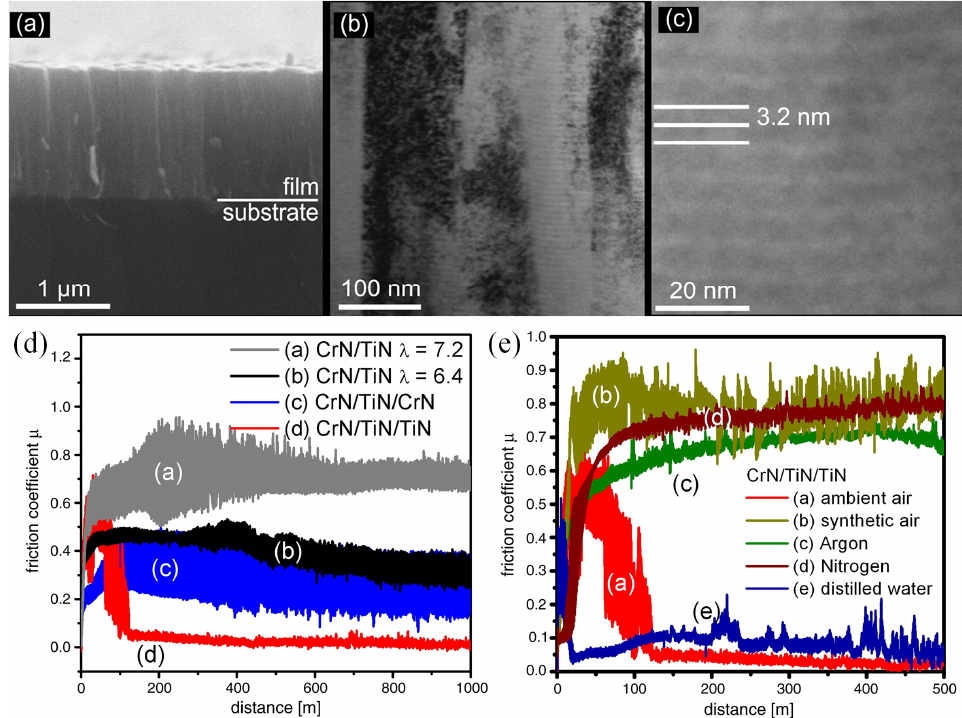
Figure 2. ( a ) SEM and ( b , c ) TEM image of multilayer CrN/TiN coating with bilayer period of 6.4 nm; ( d ) COF of different multilayer coatings under ambient condition; ( e ) COF of CrN/TiN/TiN coating under different environment conditions. Reprinted with permission from [78].